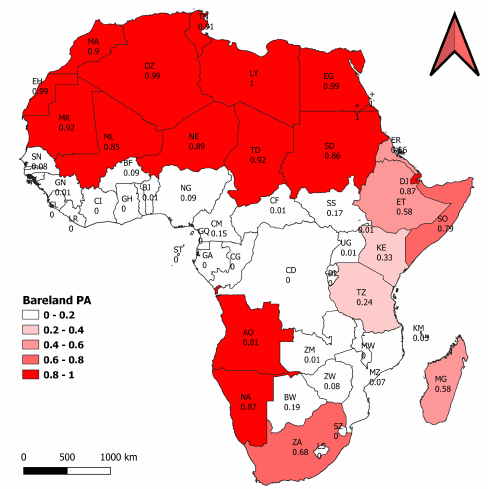
Figure 4. PA for Bareland per country